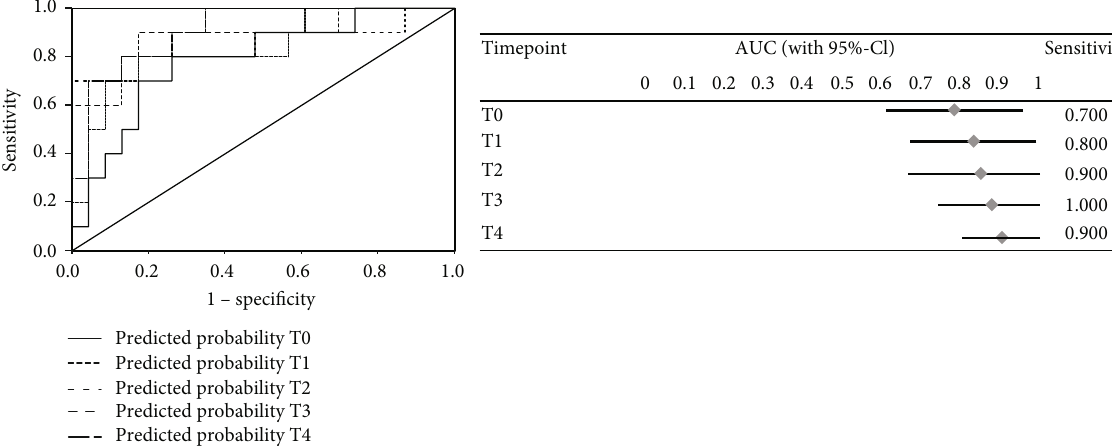
Figure 5: ROC analyses for combined measurements of MR-proADM and sICAM-1 for the detection of an IFI in patients with septic shock. Receiver operating characteristic (ROC) analyses with MR-proADM and sICAM-1 in all participating patients at septic shock onset (T0), day 1 (T1), day 2 (T2), day 7 (T3), and day 14 (T4) afterwards with regard to the prediction of an invasive fungal infection (IFI) up to day 28. Patients su ff ering from an invasive fungal infection (IFI) represented the target group, whereas both patients with a fungal colonization and patients without any fungal isolates served as controls for this ROC analysis. Abbreviations: AUC: area under the curve; CI: con fi dence